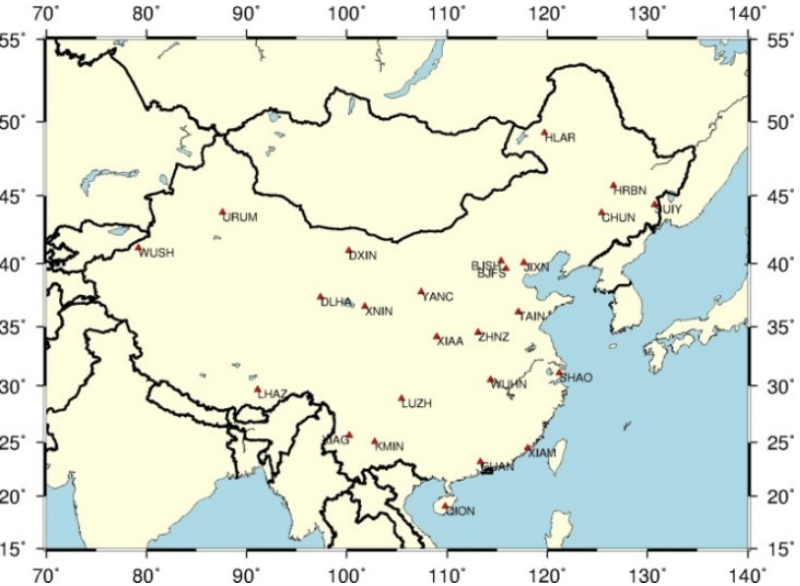
Figure 1. Distribution of 25 selected stations of CMONOC used in this study.